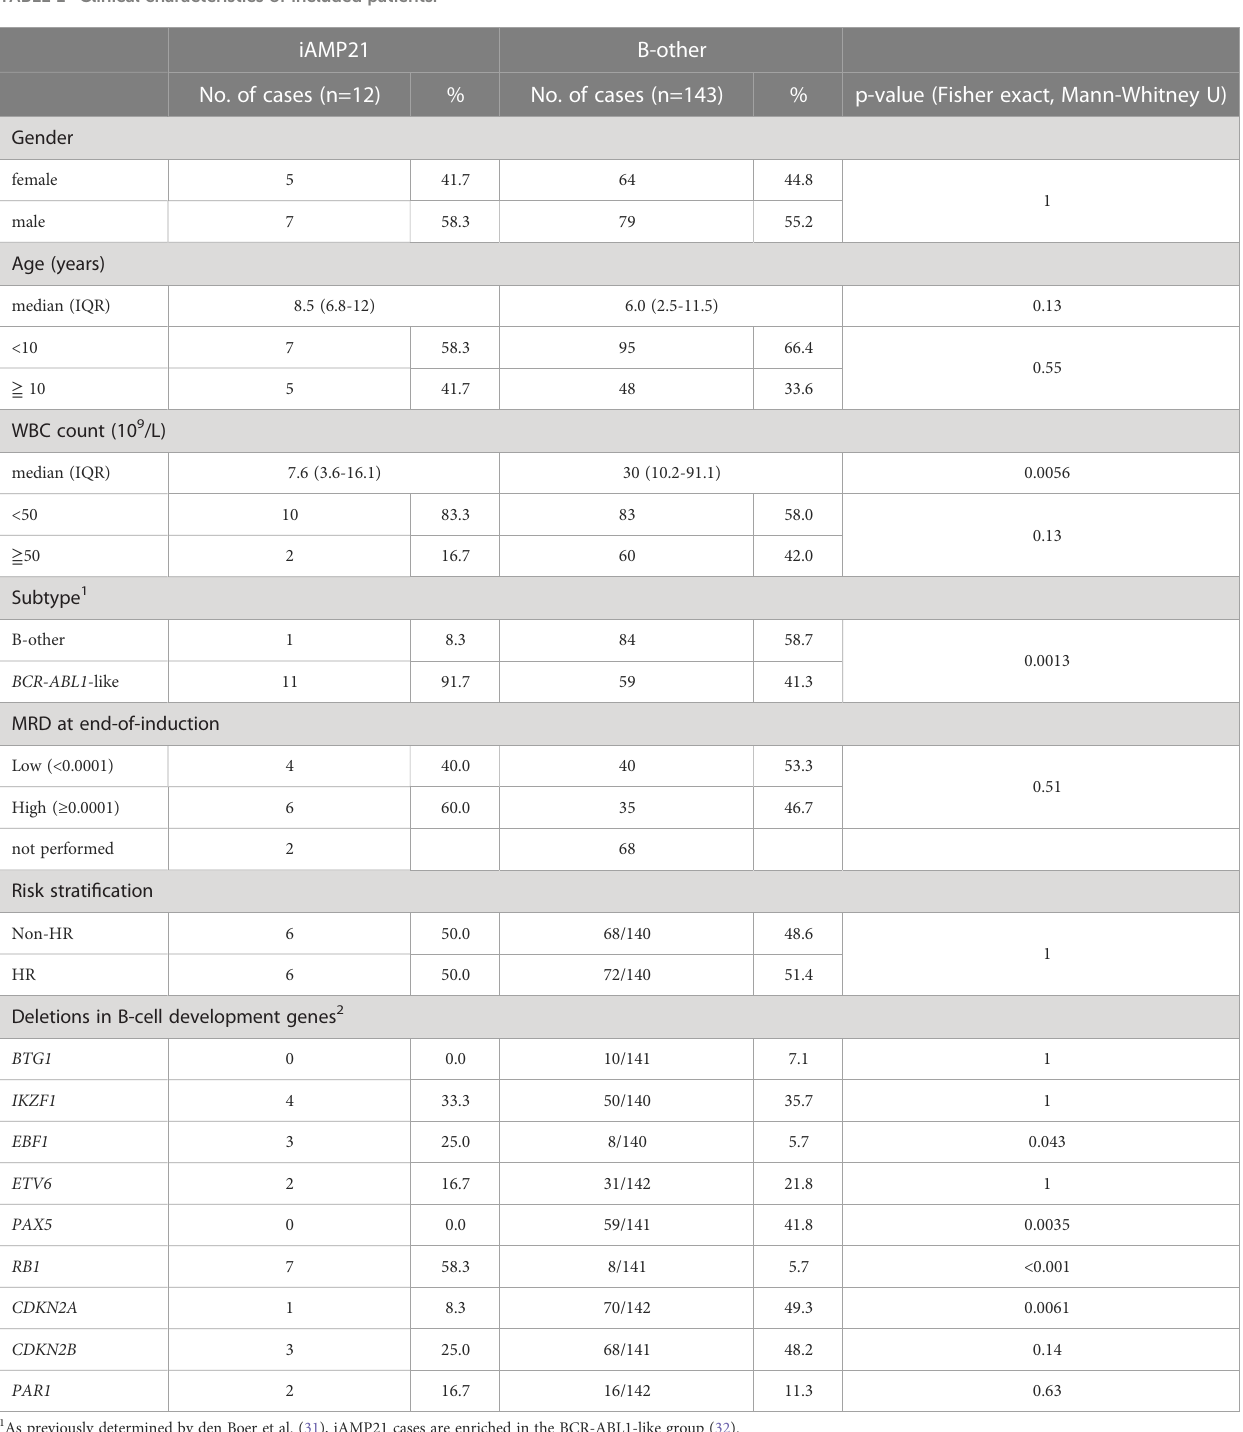
TABLE 1 Clinical characteristics of included